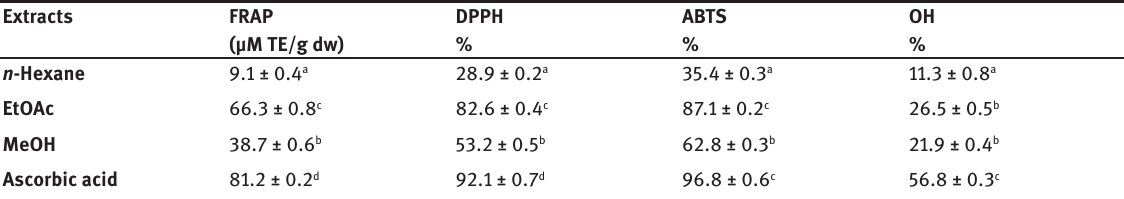
Values with different letters are significantly different at p < 0.05; All determinations were performed in triplicate (mean ± S.E.M.)